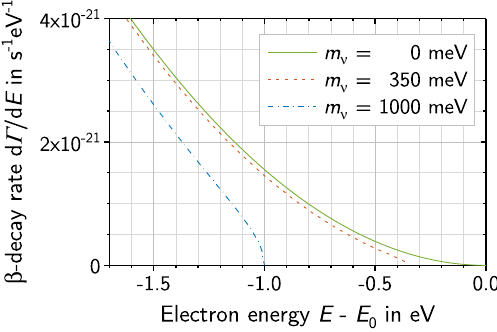
Fig. 2 The differential β -electron energy spectrum near the endpoint forthedecayofmoleculartritiumasgivenbyEq.(4),undertheassump- tion of various neutrino masses m